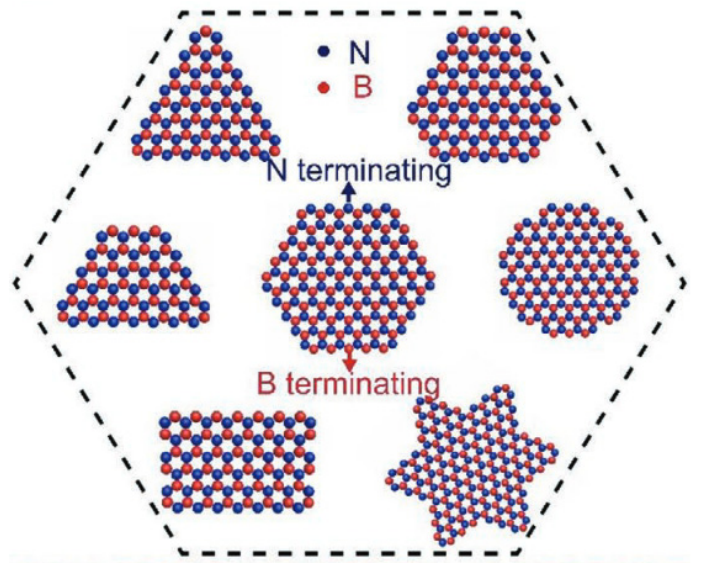
Figure 12. Different shapes of h-BN domains with B or N atoms terminating (Reproduced with permission from ref. [178]; Copyright 2018 RSC Publications.).